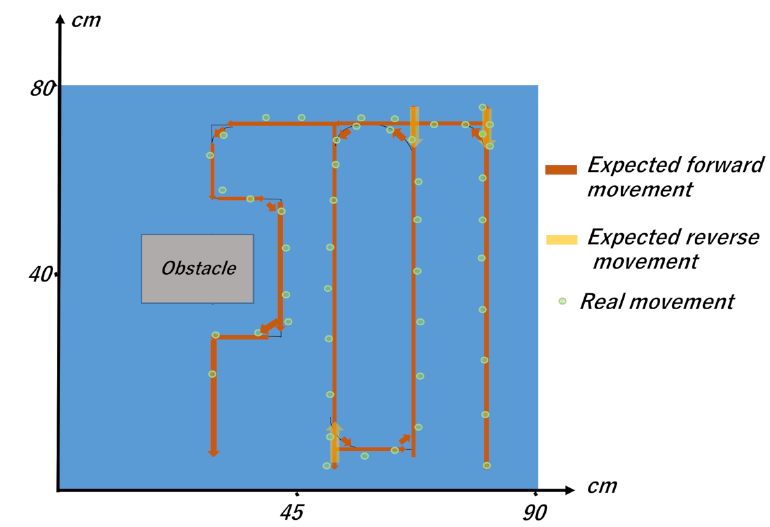
Figure 16. Trajectory of the expected travel and the real robot movement.